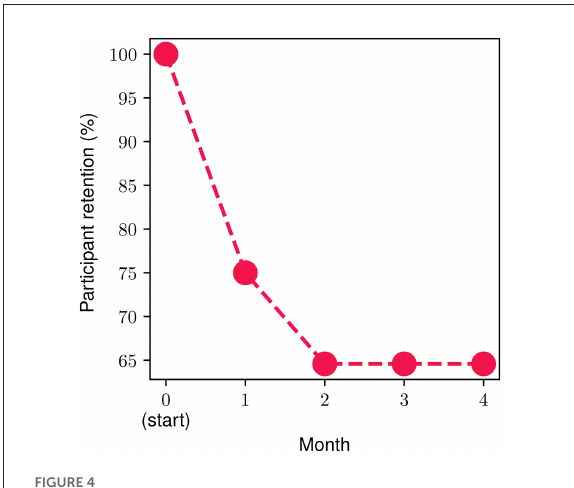
FIGURE4 Participant monthly retention during the